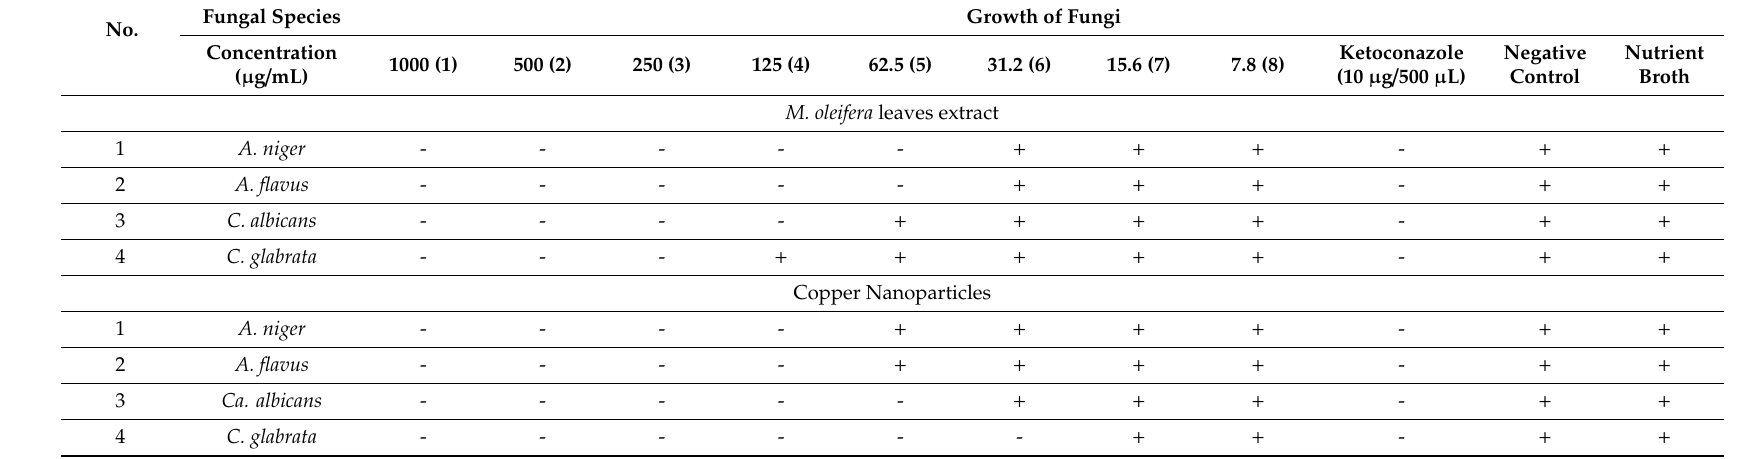
Table 8. Anti-fungal activity data (growth ( + ) and no growth